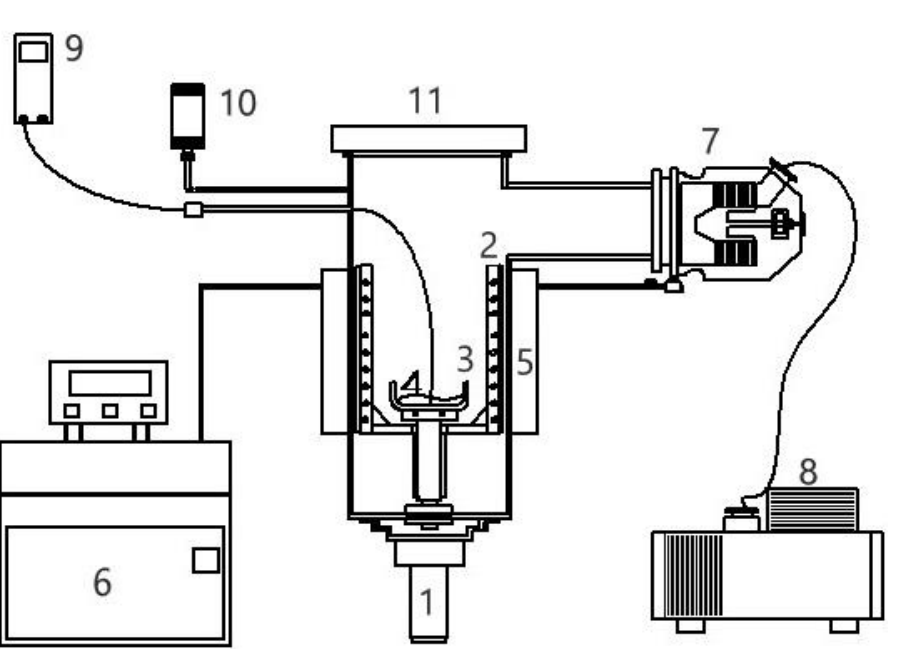
Figure 6. Schematic diagram of the experimental apparatus for SC with the features: (1) magnetic- driven motor, (2) rotating scraper, (3) sample container, (4) sample, (5) coolant jacket, (6) cooling system, (7) turbomolecular pump, (8) mechanical pump, (9) thermocouple, (10) pressure gauge, (11) transparent cover.